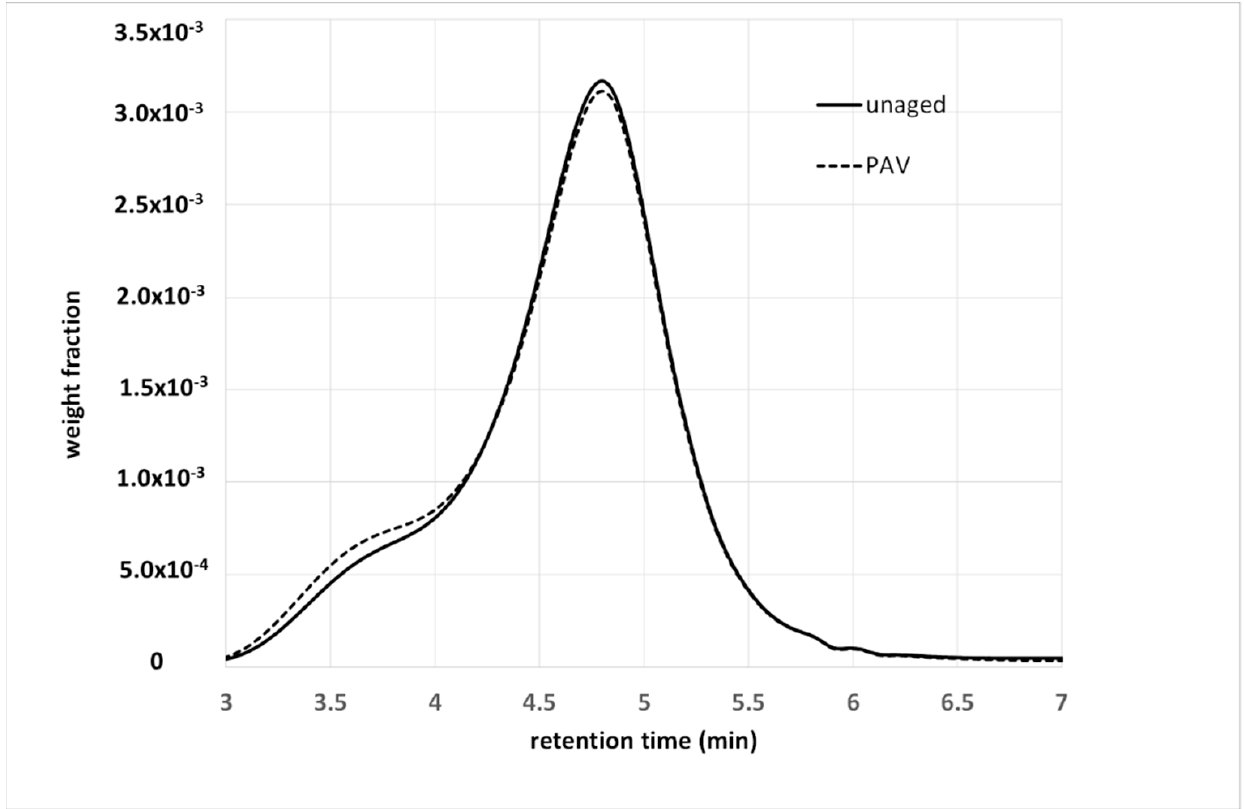
Figure 6. SMWD for a 35/50 Pen-grade base bitumen, before and after being subjected to a pressure- aging vessel (PAV).